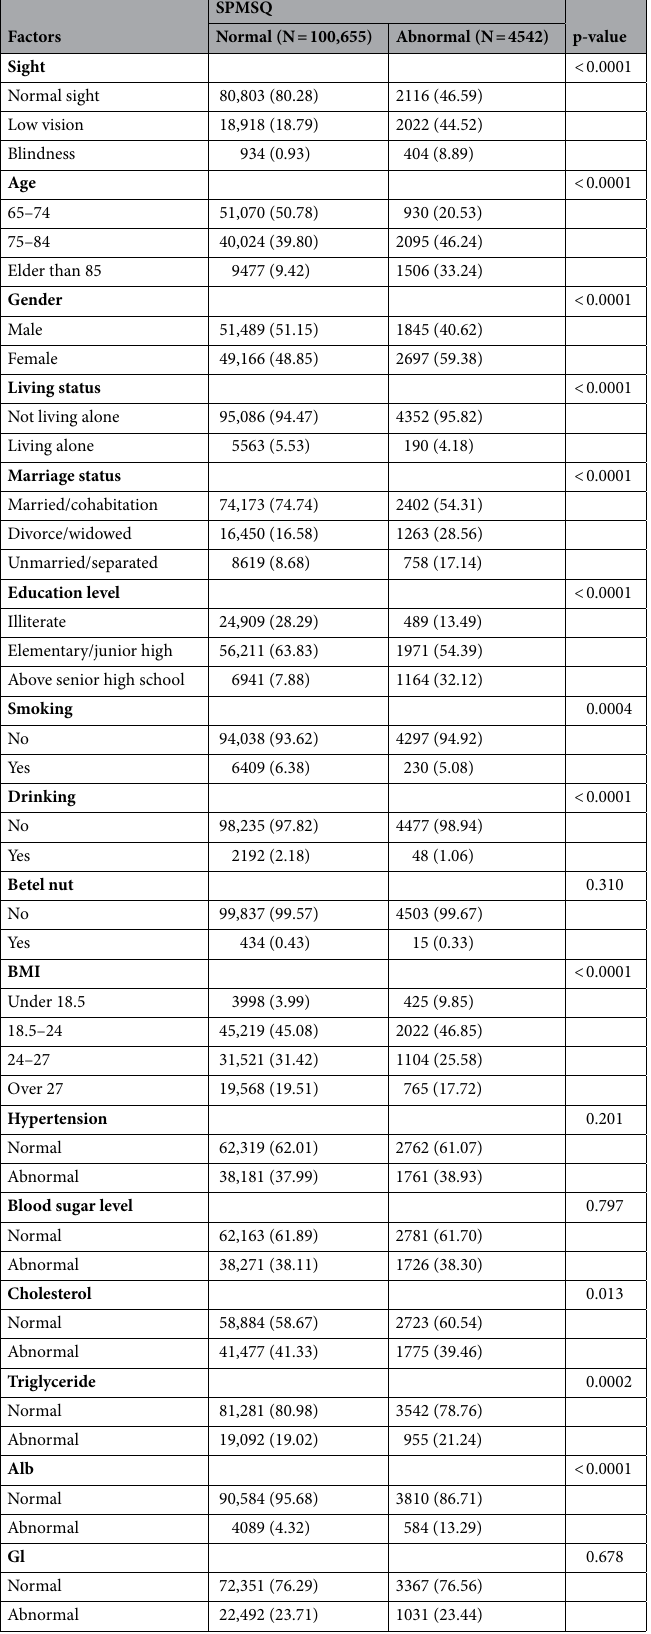
Table 1. Characteristics of normal and abnormal SPMSQ